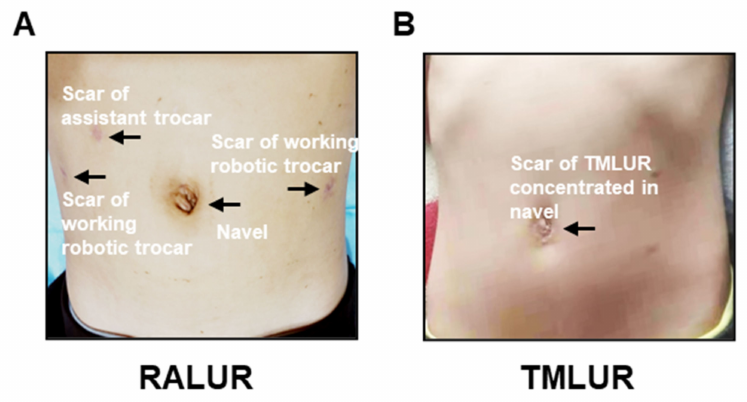
Figure 3. Postoperative scar in abdominal wall. ( A ) Postoperative scar in abdominal wall of RMLUR. ( B ) Postoperative scar in abdominal wall of